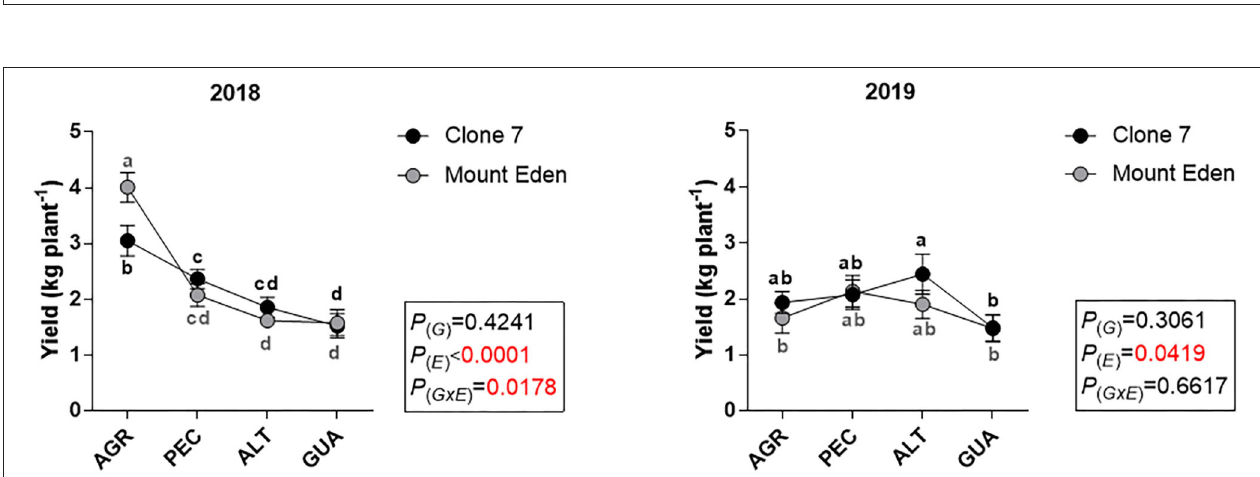
FIGURE 2 | PCA of minimum and maximum daily air temperatures, thermal amplitude and precipitation measured in the AGR, PEC, ALT and GUA vineyards during the 2018 and 2019 growing seasons (September–April). daily maximum (Tmax; ◦ C), minimum (Tmin), thermal amplitude (Tamp) and precipitation (Prec).